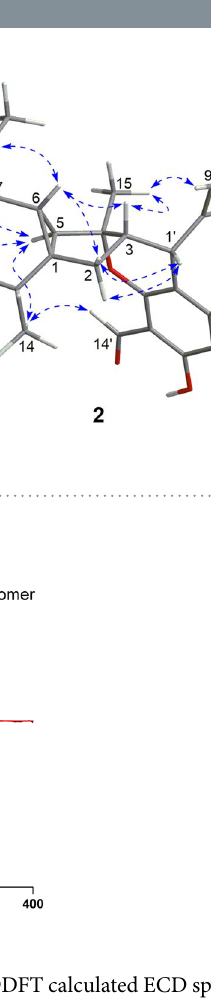
(Fig. 6). The absolute configuration of 4 (1 R , 4 R , 5 S , 9 S ) was determined to be the same as that of 17 by compari- son of their 13 C NMR, NOESY, and ECD spectra, as well as TDDFT method (Fig. 9). Psidium terpenoids usually possess a C-1 ′ coupling site on the 3,5-diformyl-benzyl phloroglucinol part 6–10 . Psiguajadial D ( 4 ) with the C-14 ′ coupling site represented the second example of this compound category, while the first example, guapsidial A ( 17 ), was reported recently from the same species 11 . Psiguajadial E ( 5 ) was assigned the molecular formula of C 30 H 33 O 5 by HR-ESI-MS, suggesting that it was an isomer of psiguadial D ( 13 ) 10 . The 1D (Tables 3 and 4) and 2D NMR analysis (see Supplementary Fig. S1.1) revealed that 5 possessed the same gross structure as that of 13 , with main differences being observed at C-3 ( δ C 40.1 in 5 , 35.3 in 13 ), C-5 ( δ C 80.1 in 5 , 85.2 in 13 ), C-15 ( δ C 26.0 in 5 , 18.6 in 13 ), and C-1 ′ ( δ C 48.6 in 5 , 43.9 in 13 ), indicating that the configuration of the coupling sites in 5 was varied. In the NOESY spectrum of 5 (Fig. 10), the key cross-peaks of H-9 ′ (13 ′ )/H-5, H-10 ′ (12 ′ )/H 3 -14, and H-1 ′ /H 3 -15 suggested that H-1 ′ and H 3 -15 were α -oriented while H-5 was β -oriented. Thus, 5 was assigned as the C-1 ′ epimer of 13 . This was further confirmed by comparison of the ECD spectra of 5 (see Supplementary S7.57) and 13 , which showed the reversed Cotton effects at 344 and 281 nm, as the Cotton effects arising from 3,5-diformyl-benzyl phloroglucinol moiety (UV λ max at 340 and 279 nm) was dominated by the configuration of the chiral carbon C-1 ′ . Thus, the structure of com- pound 5 was deduced as depicted. Psiguajadial F ( 6 ) displayed a quasi -molecular ion peak at m / z 473.2353 [M – H] − (calcd 473.2333) in HR-ESI-MS, in agreement with the molecular formula C 30 H 34 O 5 . The 1D and 2D NMR analysis revealed that 6 shared the same gross structure with psiguadial B 9 , a known caryolane-based Psidium monoterpenoid. Thus, the structural differences between the two compounds were attributable to the configurational variations on the cou- pling sites. The relative configuration of the caryolane moiety in 6 (C-1, C-4, C-8, and C-9) was assigned to be the same as those in psiguadial B by NOESY analysis (Fig. 10) and comparison of their 1D NMR data. Consequently, the NOE correlations of H-3 α /H-5 and H-9 and H-1 ′ /H-14b indicated that H-5 and H-1 ′ were α - and β - oriented in 6 , respectively, which were reversed as in psiguadial B. The absolute configuration of 6 was determined by com- parison of its ECD spectrum (see Supplementary S7.58) with that of psiguadial B, in which the reversed Cotton effects at 344 and 284 nm indicated that the configuration of C-1 ′ in 6 was S . Thus, 6 was assigned as depicted. Psiguajadial G ( 7 ) had the molecular formula C 30 H 34 O 5 as determined by HR-ESI-MS. Its 1D NMR data (Tables 3 and 4) were very similar to those of the synthesized caryophyllane-based meroterpenoid, compound